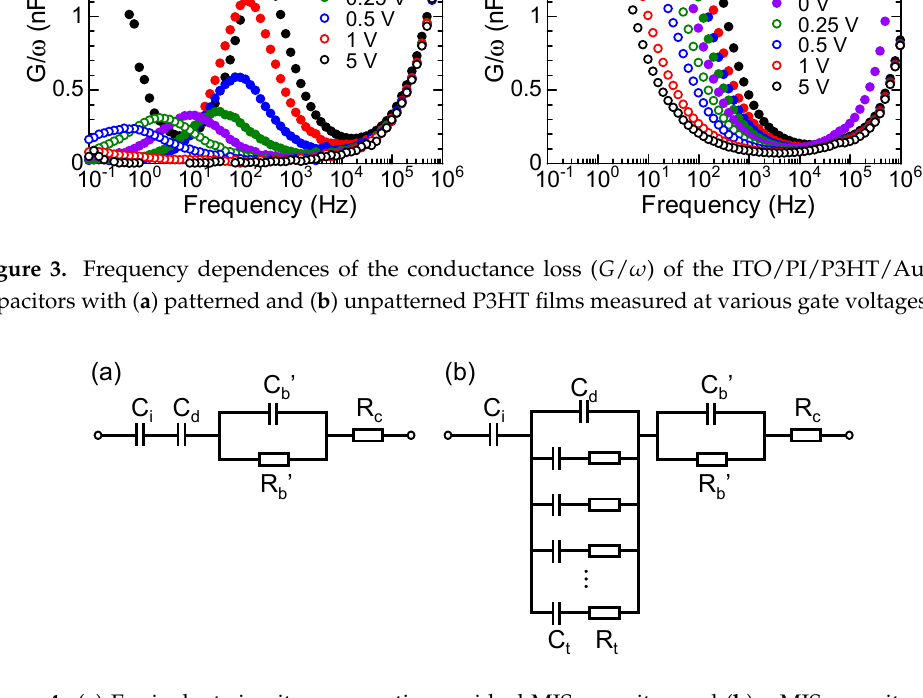
Figure 4. ( a ) Equivalent circuits representing an ideal MIS capacitor and ( b ) a MIS capacitor with energetically distributed interface states.